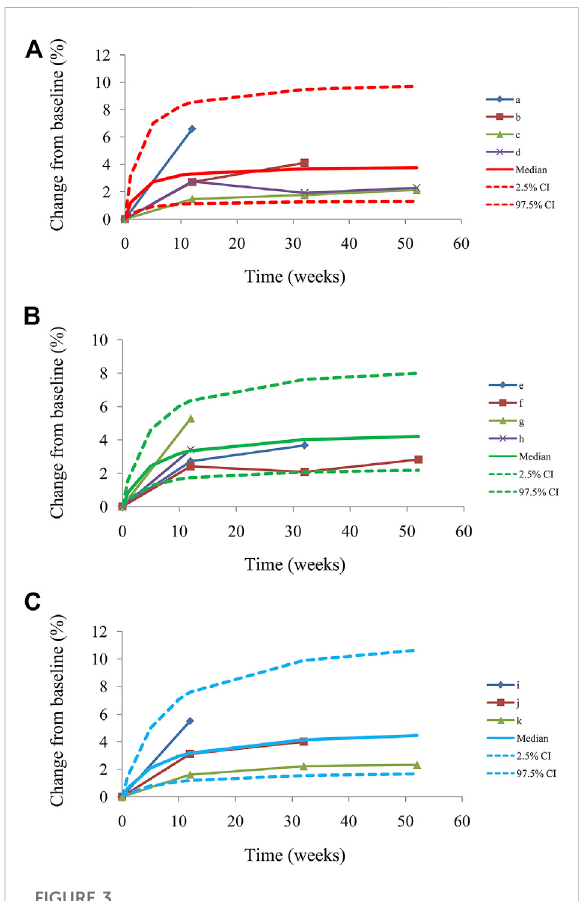
FIGURE 3 Visual predictive check plots from CSS (A) , from TSS (B) , from OSS (C) ,anda – kfromthestudies(Kosiborodetal.,2020;Abraham et al., 2021; Butler et al., 2021; Nassif et al., 2021; Butler et al., 2022a). Median, 2.5% CI and 97.5% CI were simulated by the Monte Carlo method (n = 1,000); CI, con fi dence interval. CSS: clinical summary score; TSS: total symptom score; OSS: overall summary score.